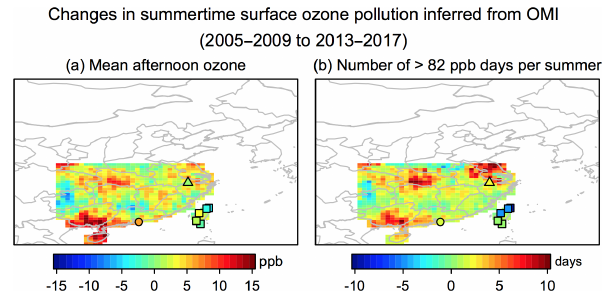
Figure 6. Changes in surface ozone pollution between the 2005– 2009 and 2013–2017 periods (separated by 8 years) as inferred from OMI afternoon observations at around 13:30 local time. (a) Change in mean summer afternoon concentrations, obtained from the differ- ence in the mean OMI ozone enhancements and applying Eq. (1). Also shown with symbols are observed changes in mean MDA8 ozone from in situ observations in Lin’an, Hong Kong and Taiwan reported by TOAR (Schultz et al., 2017). Because the TOAR obser- vations are only reported for 2005–2014, we estimate the changes from 2005–2009 to 2013–2017 on the basis of the reported linear trends during 2005–2014 (ppba − 1 ) . (b) Change in the number of high-ozone days ( > 82ppb) per summer, calculated by applying the probability of exceeding 82ppb (Eq. 8) to the daily OMI enhance- ments. Also shown with symbols are observed changes of the num- ber of days with MDA8 ozone exceeding 80ppb at the TOAR sites, similarly adjusted as the change from 2005–2009 to